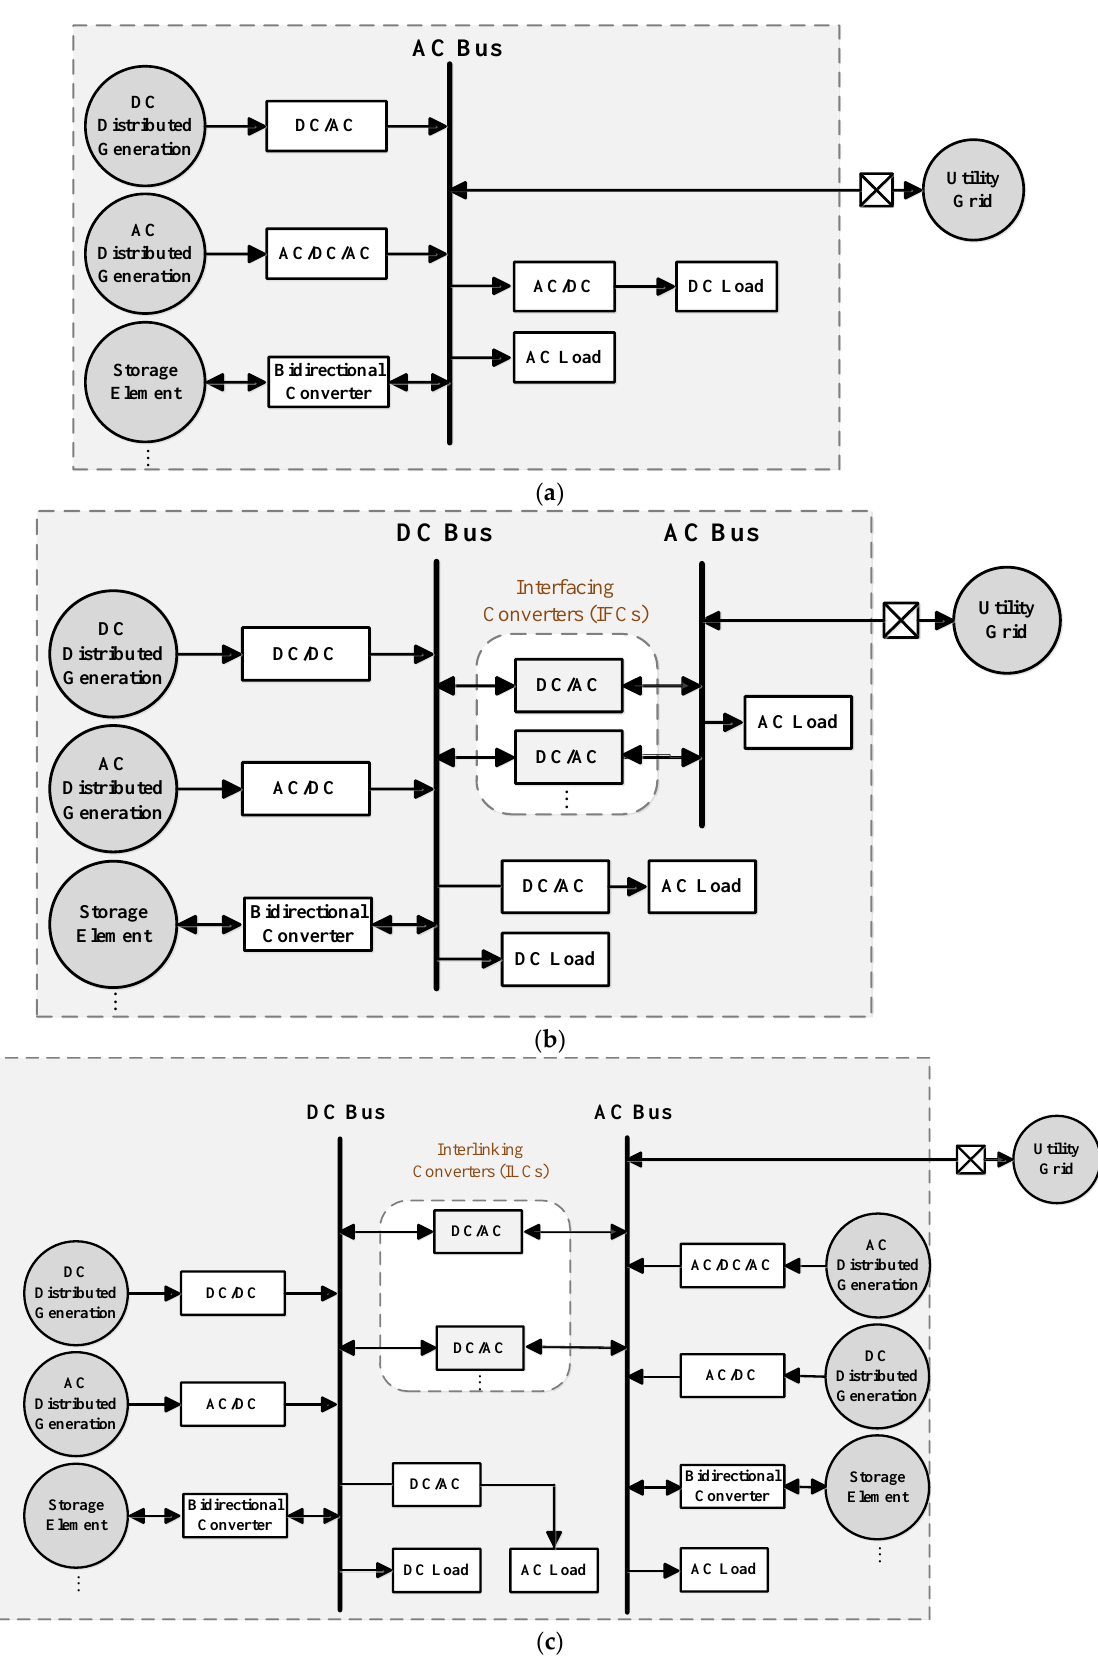
Figure 1. ( a ) AC coupled, ( b ) DC coupled, and ( c ) AC-DC coupled hybrid microgrid [9].